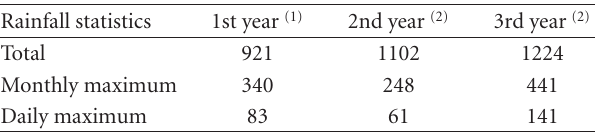
Table 3: Some rainfall statistics (mm) at or near the experimental site during May and September in each